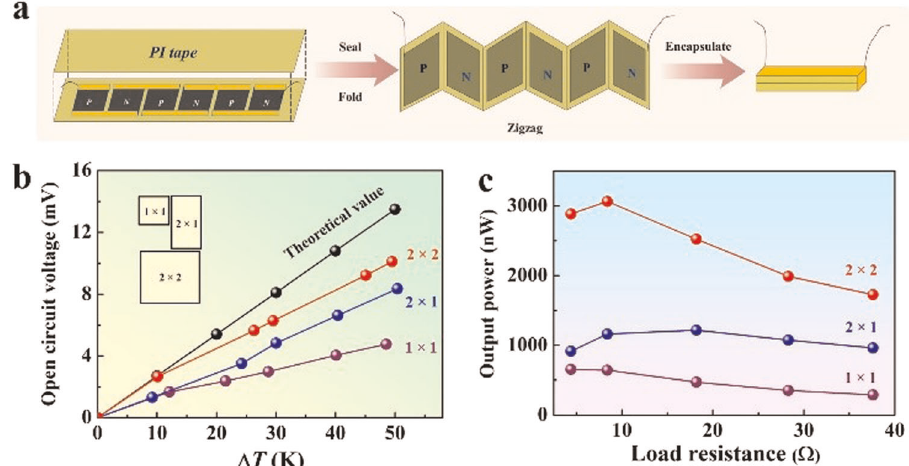
Fig. 2 An individual TE module. a Schematic illustration of the fabrication procedure of a TE module composed of three p-n couples with different fi lm sizes (1 × 1 cm 2 , 2 × 1 cm 2 , and 2 × 2 cm 2 ). b Dependence of open circuit voltage with temperature gradient ( Δ T ) for the theoretical values and the measured data of a TE module. c Effect of the module load resistance on the output power at Δ T = 45